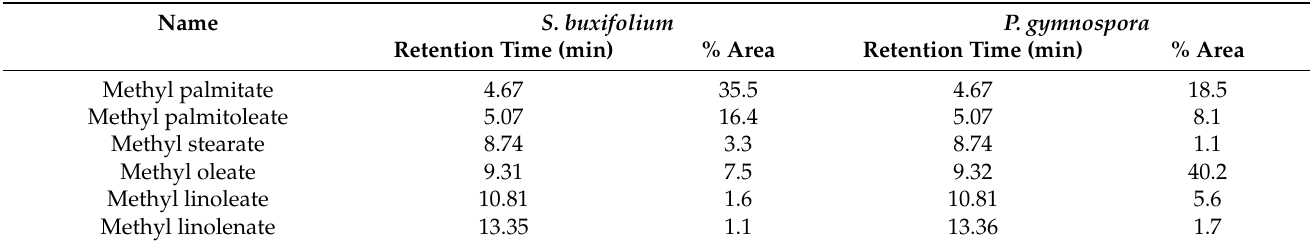
Table 2. Identification of FAMEs in hexanic extracts of S. buxifolium and P. gymnospora .